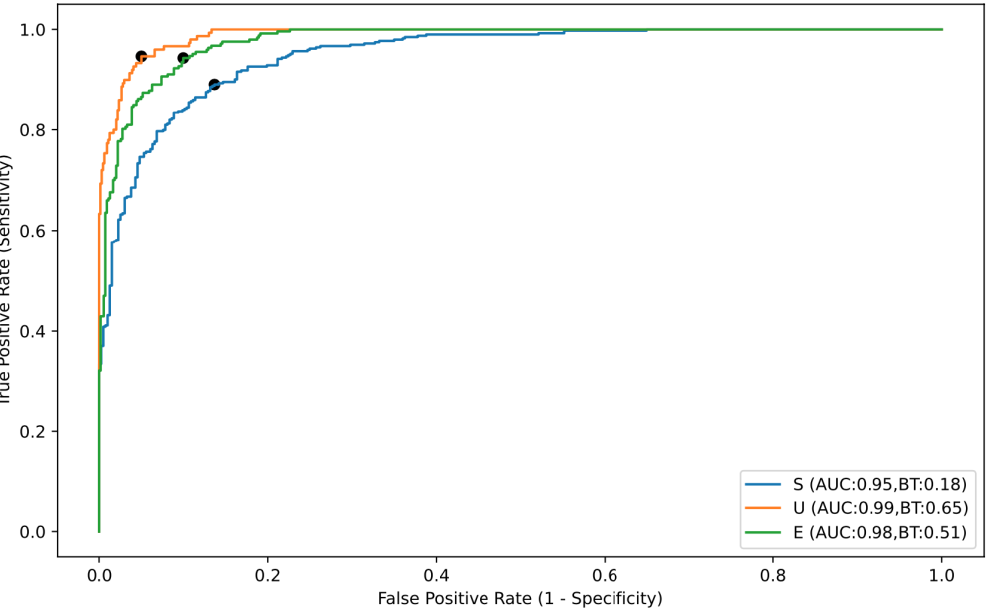
Figure 3. Receiver operating characteristic (ROC) curve of the convolutional neural network’s performance in differentiating the small-bowel preparation classes: AUC, area under the ROC curve. (BT—best threshold).